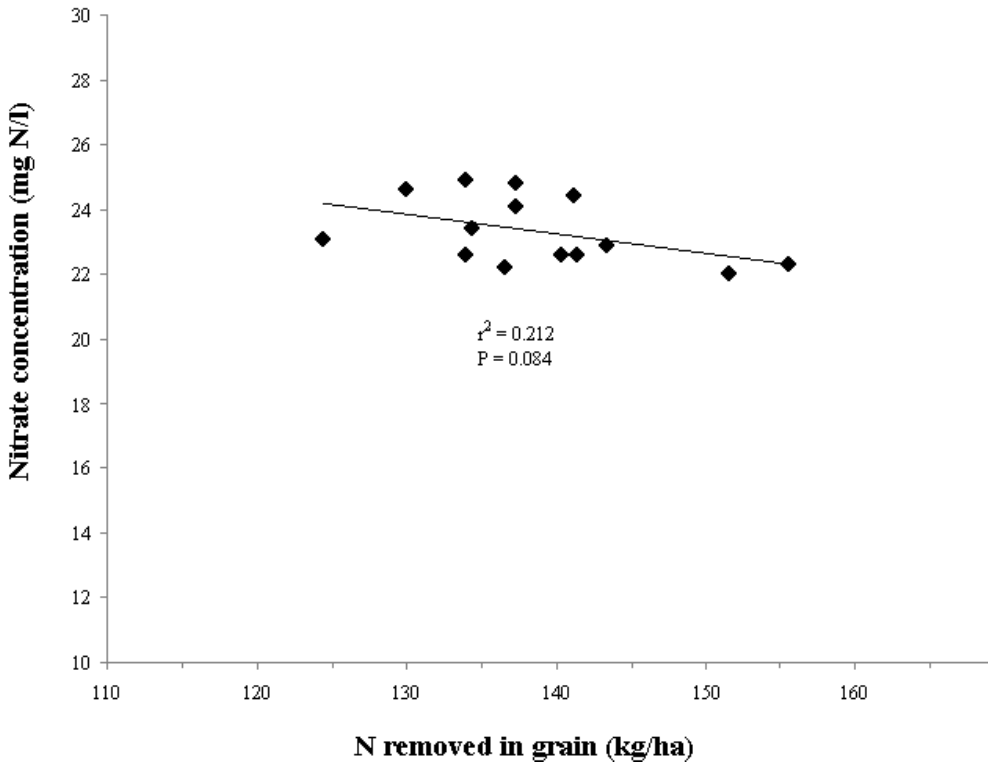
FIGURE 4. Relationship between groundwater nitrate concentrations in the primary aquifer beneath the terrace and N removed in